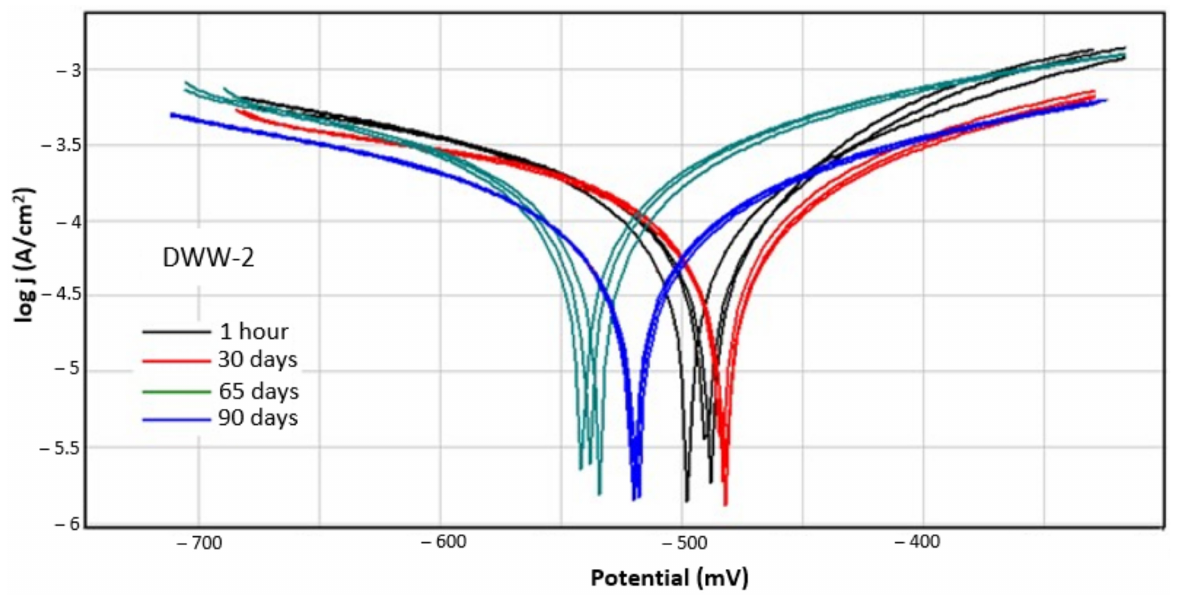
Figure 2. Polarisation curves for nodular cast-iron immersed at various time intervals in DWW-2.